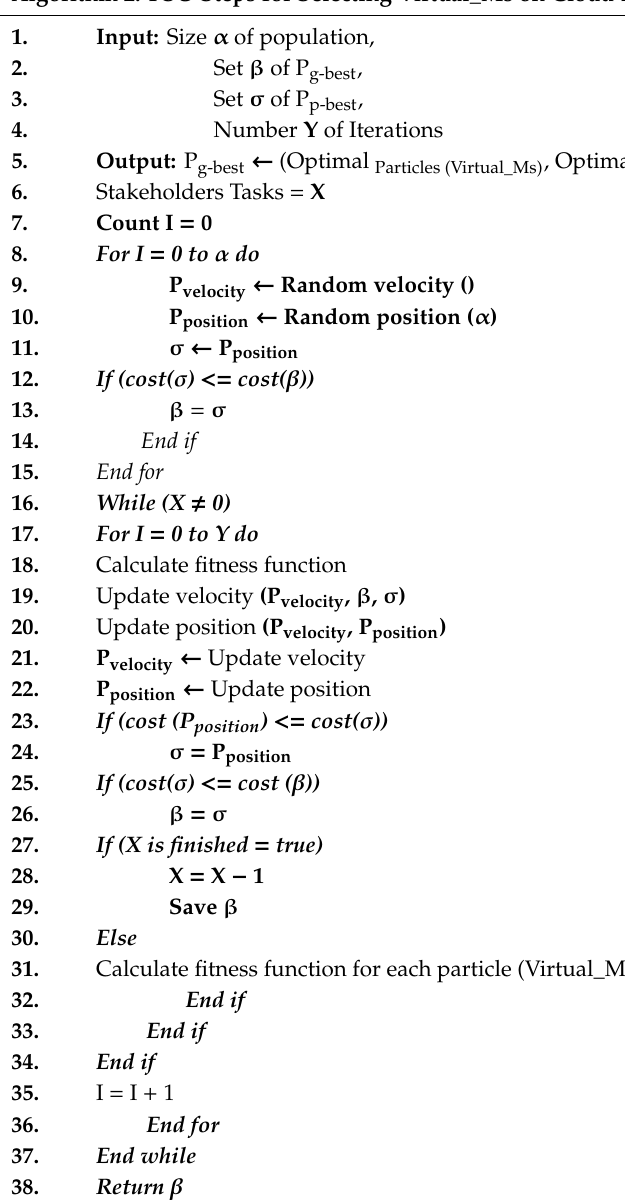
Algorithm 2. PSO Steps for Selecting Virtual_Ms on Cloud